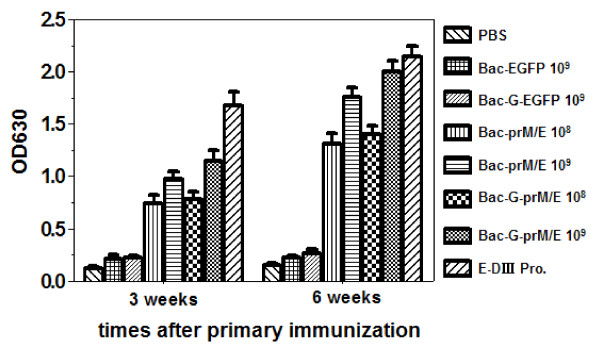
WNV-specific ELISA antibody titers in mice immunized with recombinant baculoviruses. Mice were intramuscularly vaccinated with recombinant baculovirus Bac-G-prM/E or Bac-prM/E, or control virus, while E-DIII protein vaccine used as a positive control (for details, see materials and methods, mouse immunization). Serum samples were collected at 3 and 6 weeks after the fist immunization. Presence of antibodies was analyzed by ELISA at a 1:500 serum dilution. The data are expressed as average titers per group (n = 6) ± SD.